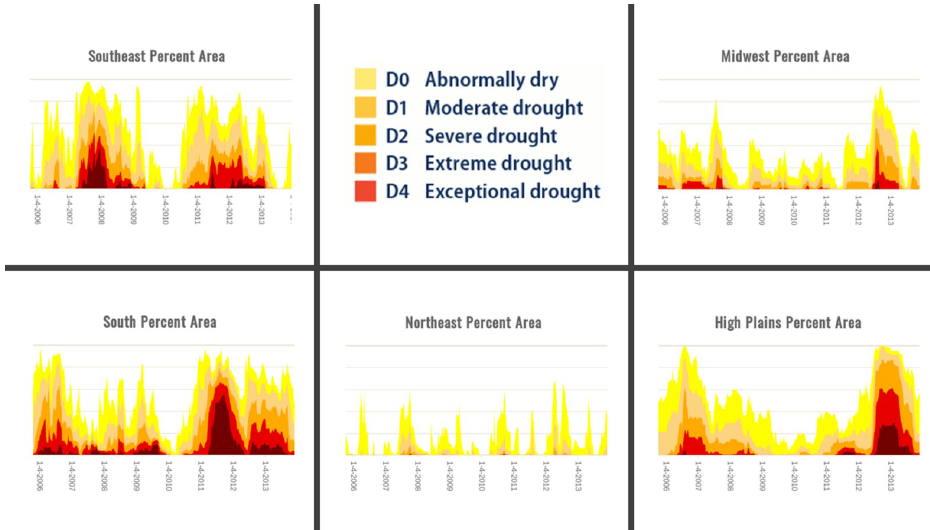
Fig 1. Percentage land coverage during drought conditions (2006–2013) by NADM climate regions encompassing the breeding range of Eastern Bluebirds ( Sialia sialis ). Modified from and courtesy of the National Drought Mitigation Center (NDMC). The U.S. Drought Monitor is jointly produced by the NDMC at the University of Nebraska-Lincoln, the U.S. Department of Agriculture, and the National Oceanic and Atmospheric